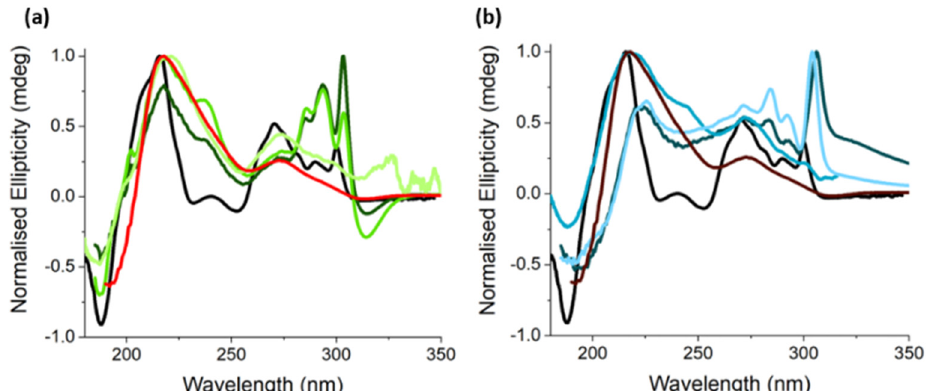
Figure 3. CD spectra of single-component control hydrogel samples—FY gel prepared by hydrolysis of GdL (black) or Ag-GMP gel (1:1 (red) and 2:1 (brown)). ( a ) Hydrogel samples prepared using a 1:1 Ag:GMP molar ratio and varying FY concentrations, samples A ( ― ), B ( ― ), and C ( ― ) and ( b ) at 2:1 Ag:GMP stoichiometry and FY varying concentrations; samples D ( ― ), E ( ― ), and F ( ― ). Refer to Table 1.